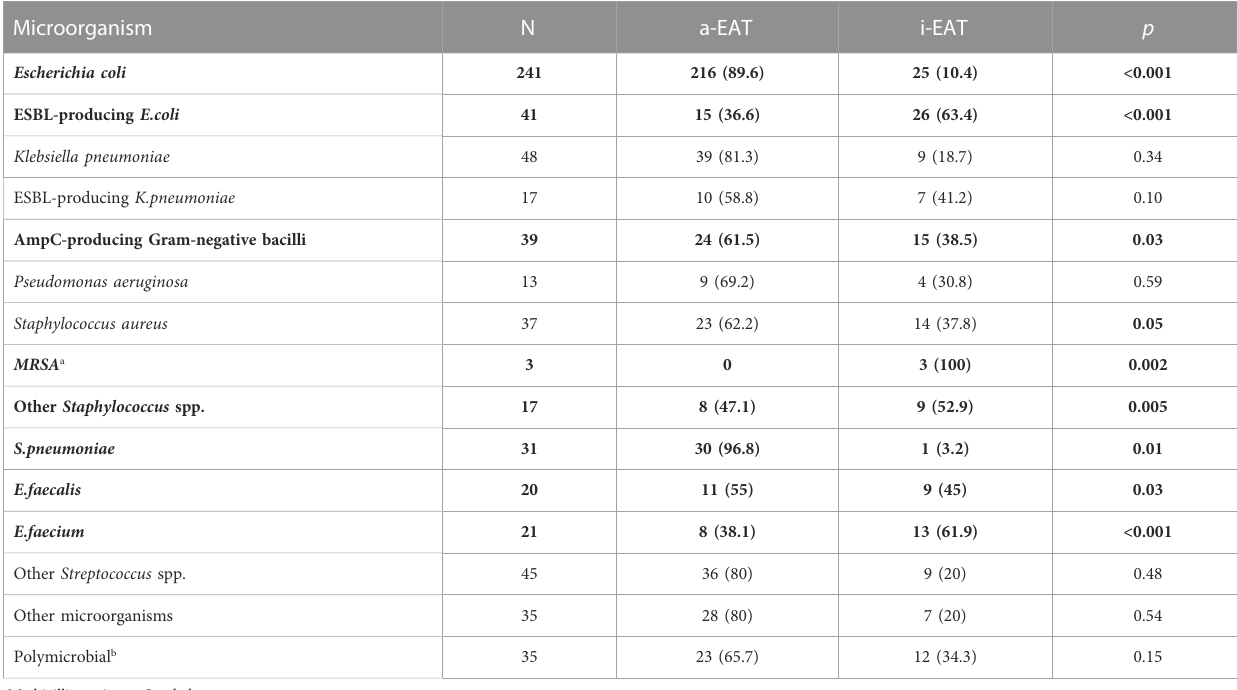
TABLE 2 Etiology of the BSI episodes and antimicrobial appropriation.